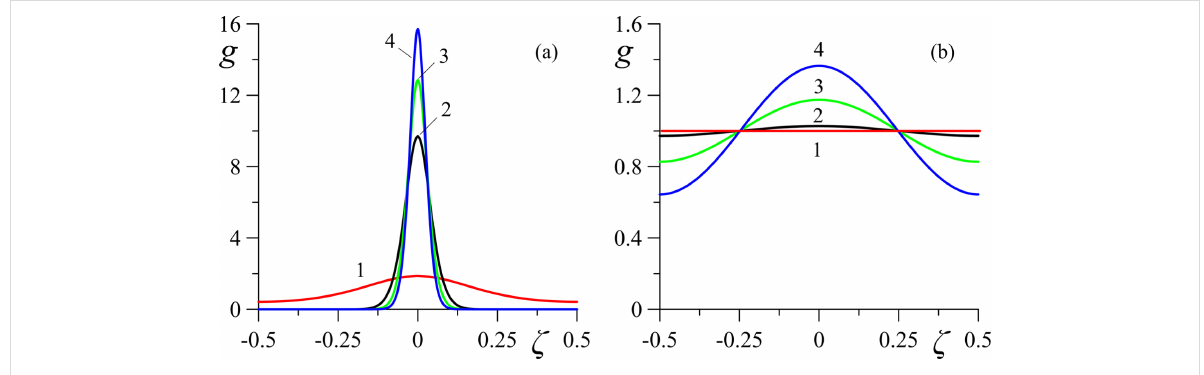
Figure 6: Spatial distributions of the reduced CNT volume fraction g for different values of the magnetic field strength h in the case of (a) strong ( κ = 0.01) and (b) weak ( κ = 0.5) segregation of CNTs: curve 1 – h = 2.75; curve 2 – h = 2.85; curve 3 – h = 3.0; curve 4 – h = 3.2.